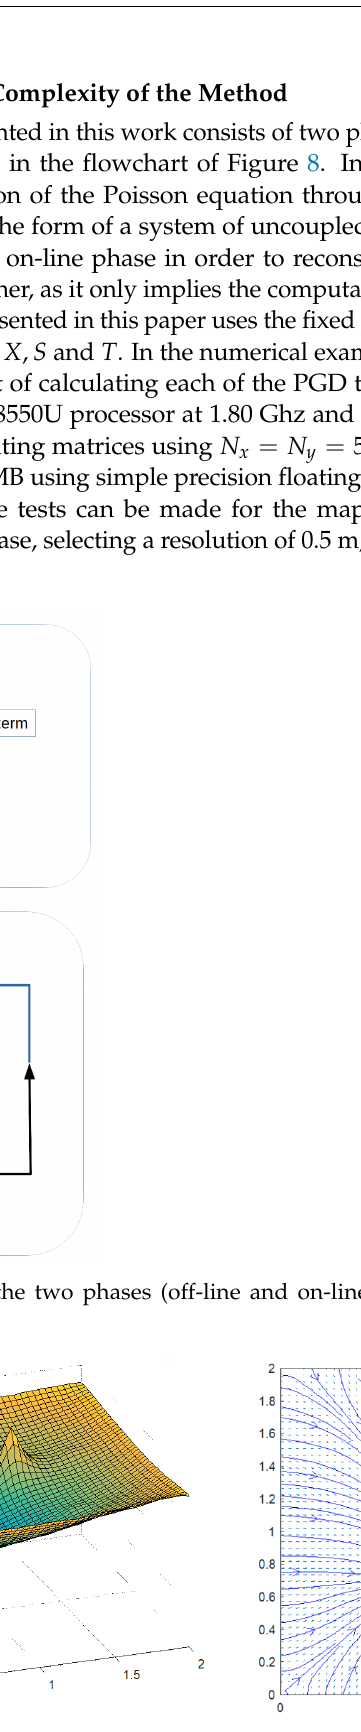
Figure 9. Numerical examples for two arbitrary S , T locations in two complex